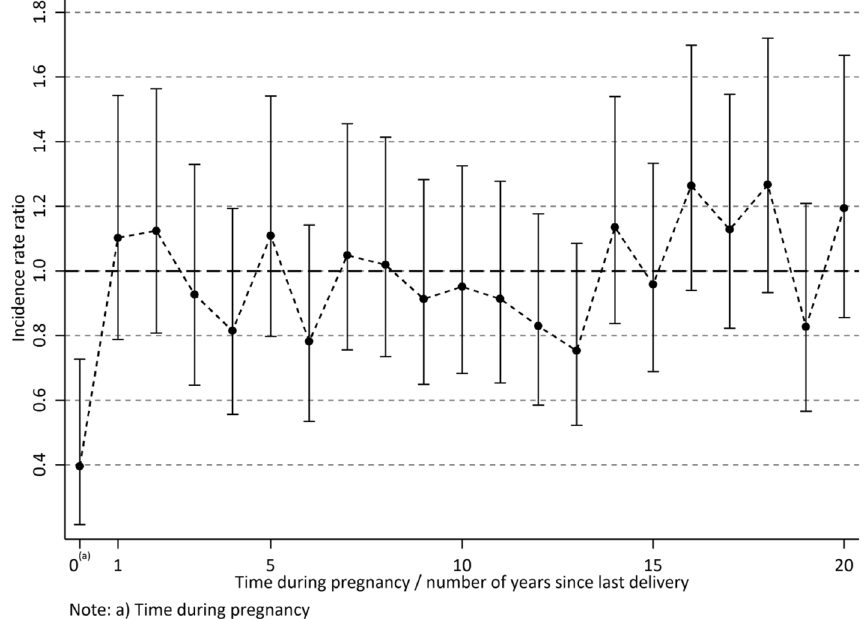
Figure 2. Incidence rate ratio with 95% confidence intervals adjusted for attained age by time during pregnancy/number of years since last pregnancy. Women with at least one delivery during the follow-up